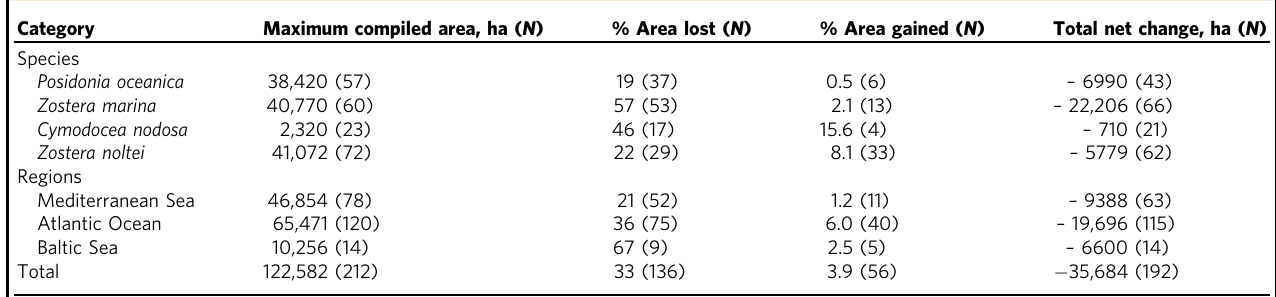
Fig. 2 Overall changes of European seagrasses per metric of change. a Percentage of seagrass sites showing decline, increase, and no change for each metric, and b speci fi c rates of change of declining and increasing sites for each metric (% yr − 1 , in absolute value). Number of sites showing decline, increase, and no change trajectories are given between brackets. In the boxplots, the plus ( + ) represents the mean, the solid line the median, the lower and upper hinges are the fi rst and third quartile, whiskers extends to the largest and smallest values no further than 1.5×inter-quartile range, and data beyond the end of the whiskers are plotted as points. Source data are provided as a Source Data fi le Table 1 Gains and losses in area of European seagrasses per species and